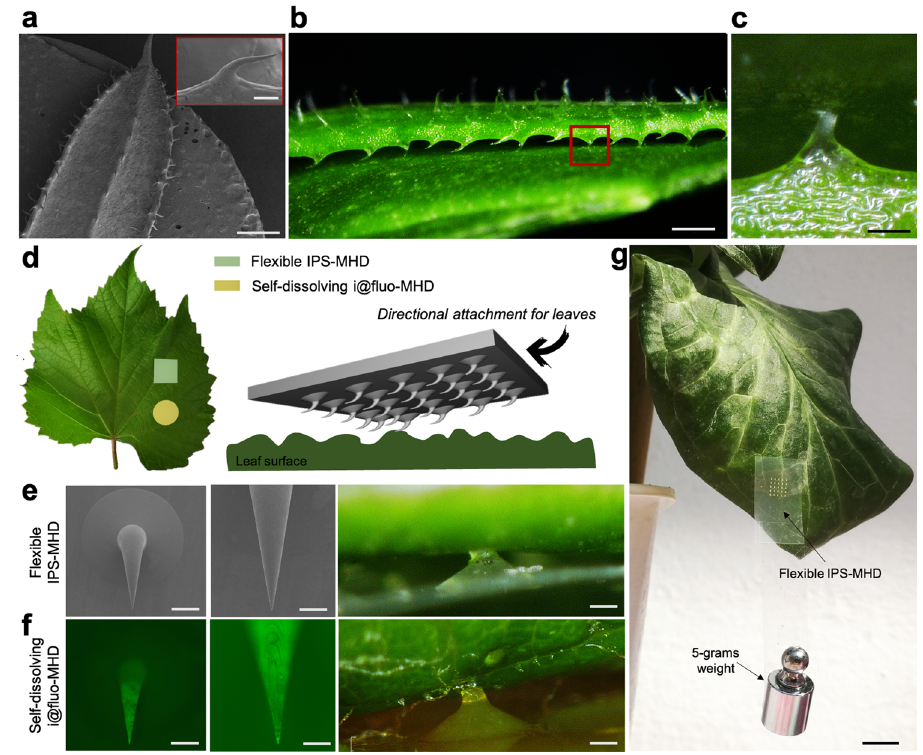
Fig. 1 From natural to arti fi cial MH-based anchoring devices for plant leaves. a SEM images of G. aparine natural abaxial leaf side (scale bar, 1 mm) and close up of natural abaxial microhook (inset, scale bar, 150 µ m). b, c Digital microscope images of G. aparine leaf on a host plant (scale bar, 500 µ m) and focus on natural abaxial microhook interlocking with the leaf surface (scale bar, 200 µ m), respectively. d MH-based directional attachment system on leaves. e Arti fi cial hooks of fl exible IPS-made MH-based devices (IPS-MHDs) and their interlocking with leaf surface (SEM images on the left). Scale bars, 100 and 25 µ m, respectively; digital microscope image on the right, scale bar, 100 µ m). f Arti fi cial hooks of self-dissolving isomalt@ fl uorescein-made MH- based devices (i@ fl uo-MHDs) and its interlocking with leaf surface ( fl uorescence images on left. Scale bars, 200 and 50 µ m, respectively; digital microscope image on right, scale bar, 200 µ m). g Demonstration of directional attachment on Arum italicum leaves using IPS-MHDs (i.e., holding a weight of 5-grams). Scale bar: 1